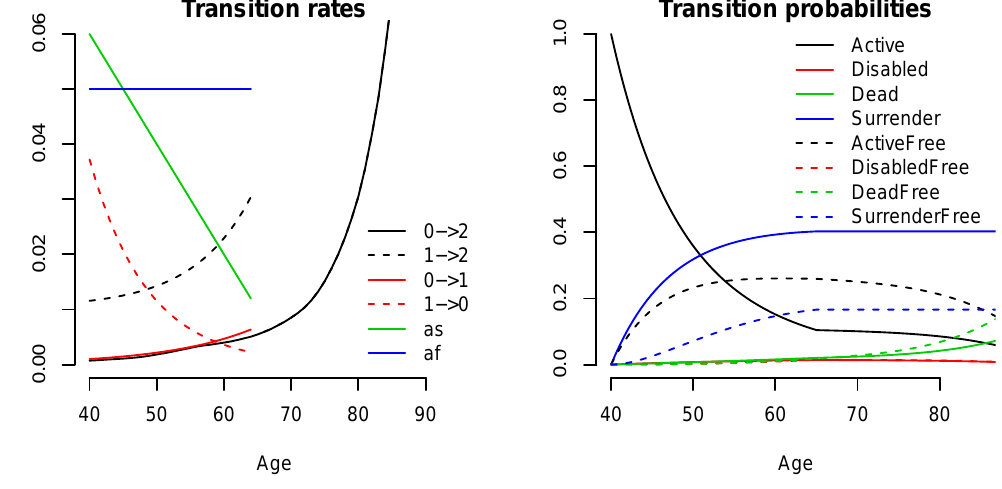
Figure 6. Transition rates (left) and transition probabilities (right). In the left figure, the transition rates between the states in the disability model, (0, active, 1, disabled, and 2, dead) are shown, as well as the surrender (active to surrender (as)) and free policy (active to free policy (af)) transition rates. In the right figure, the full lines are the non-free policy states, and the dashed lines are corresponding free policy states. The active, free policy and surrender states are dominant.